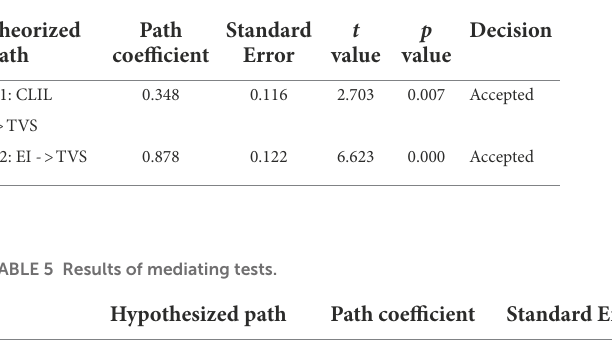
TABLE 4 Results of hypotheses testing (Direct relationships).